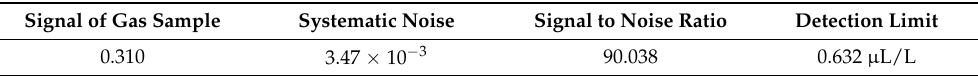
Table 3. Systematic noise and detection limit of the detection